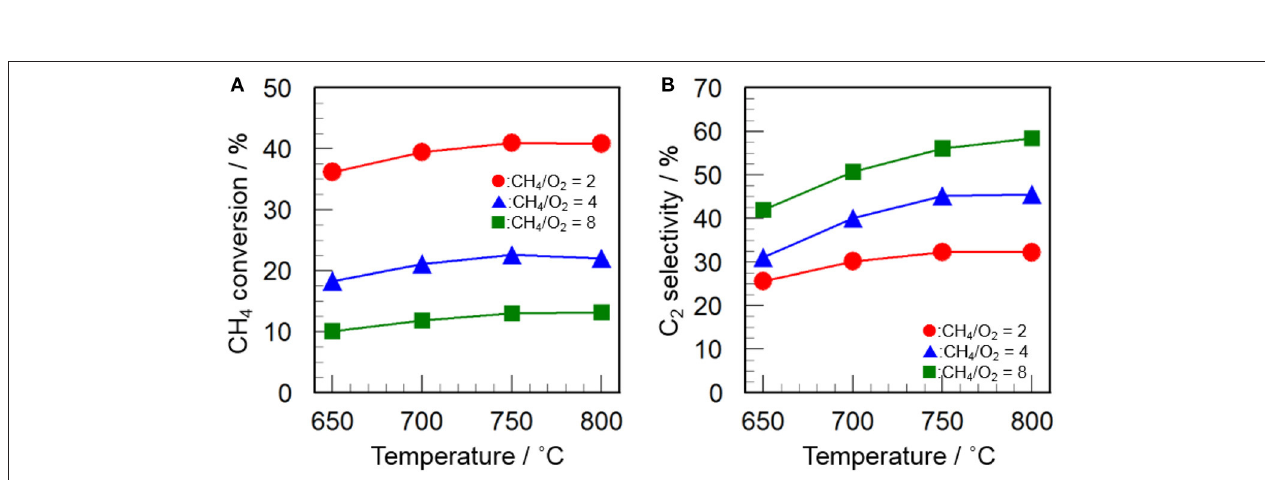
FIGURE 5 | Effect of CeO 2 loading on the activity of CeO 2 ( x )/Y 2 O 3 (CP) for the OCM reaction. (A) CH 4 conversion and (B) C 2 selectivity.